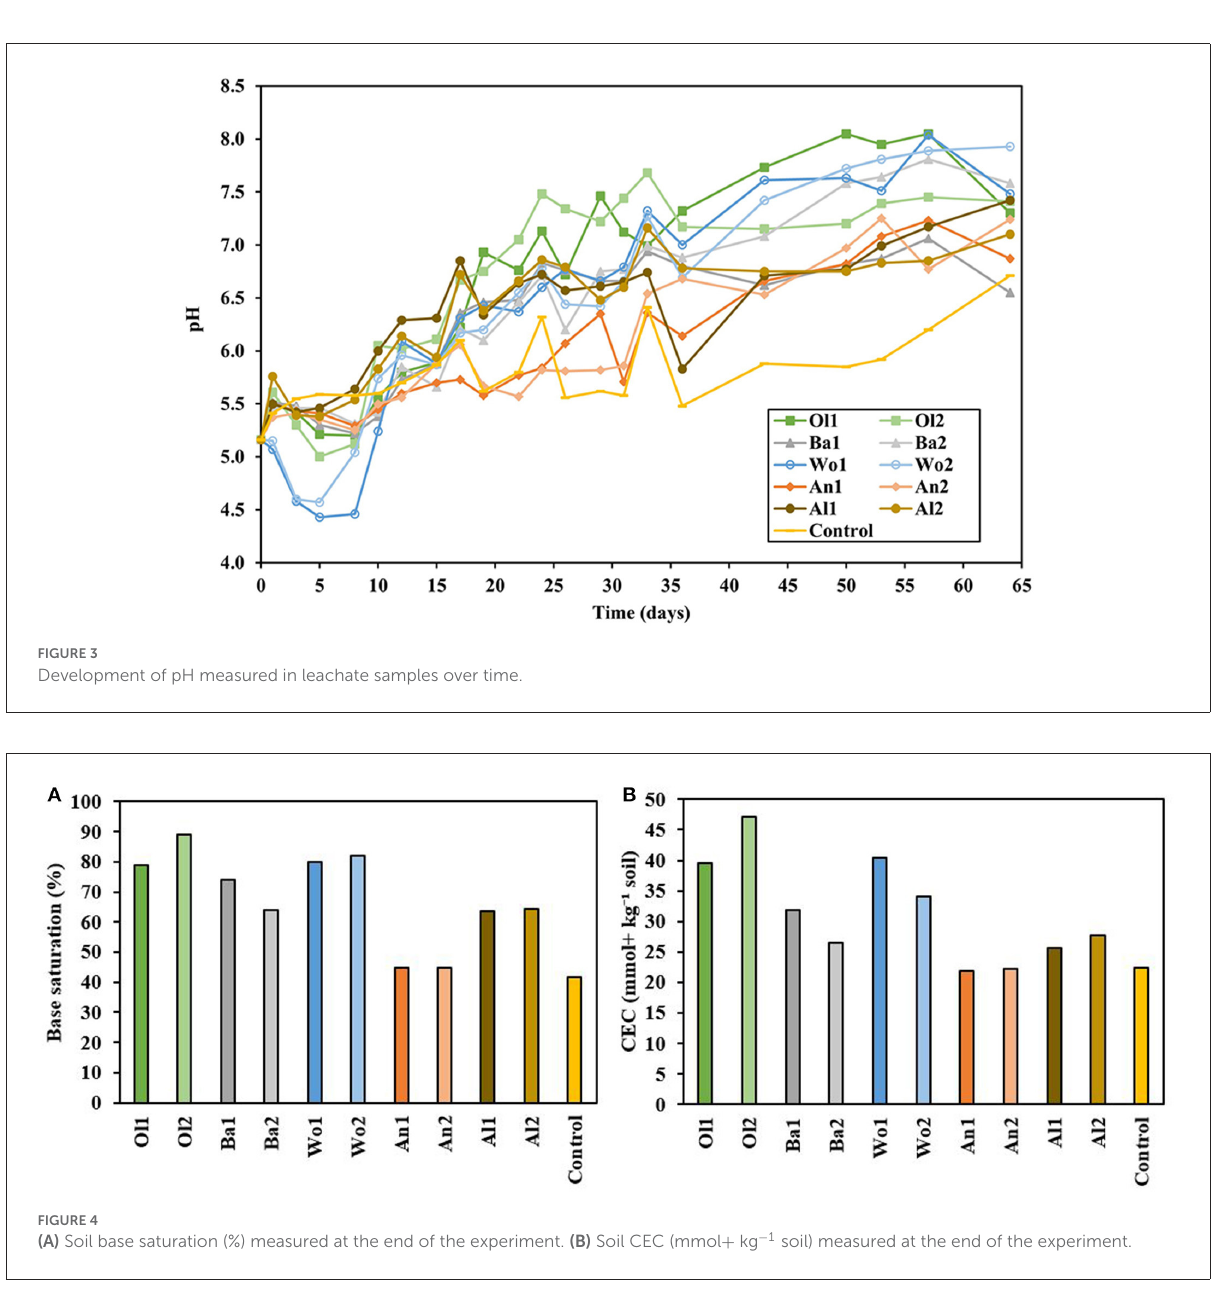
olivine (1.82–4.45 g CO 2 kg − 1 soil), and wollastonite